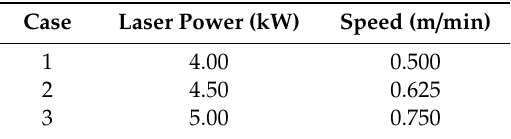
Table 5. Butt fiber laser welding conditions of high-manganese steel (15 mm thickness).